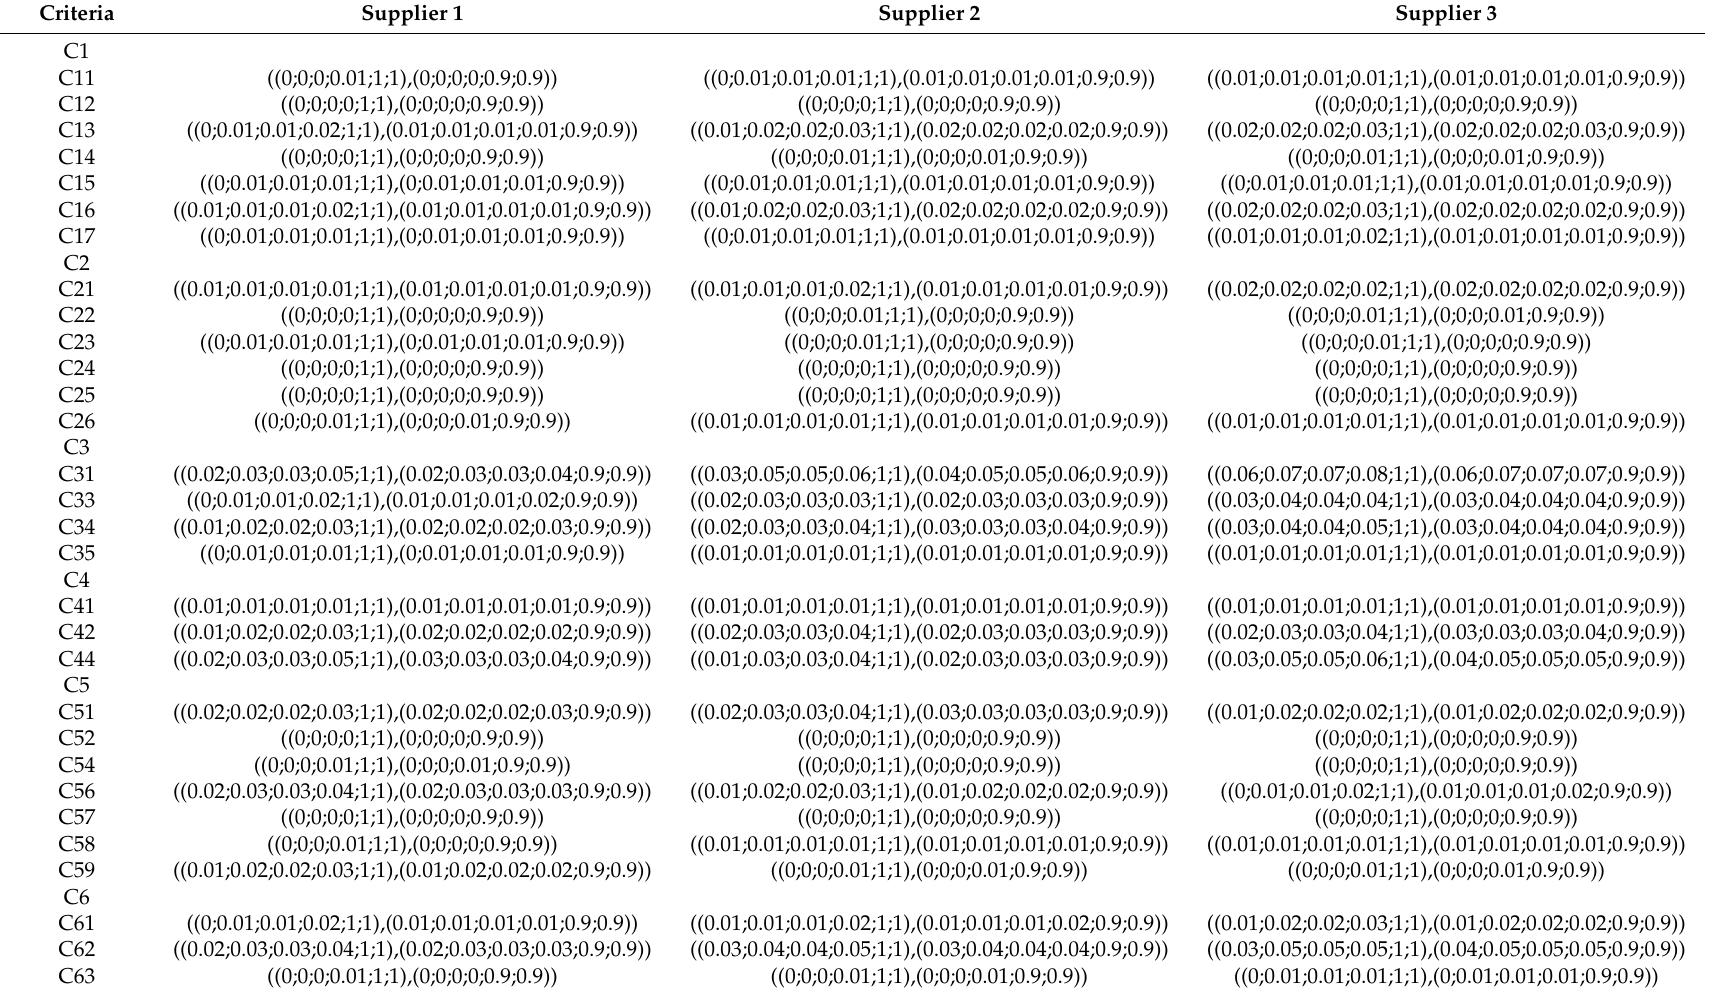
Table 6. The weighted evaluation